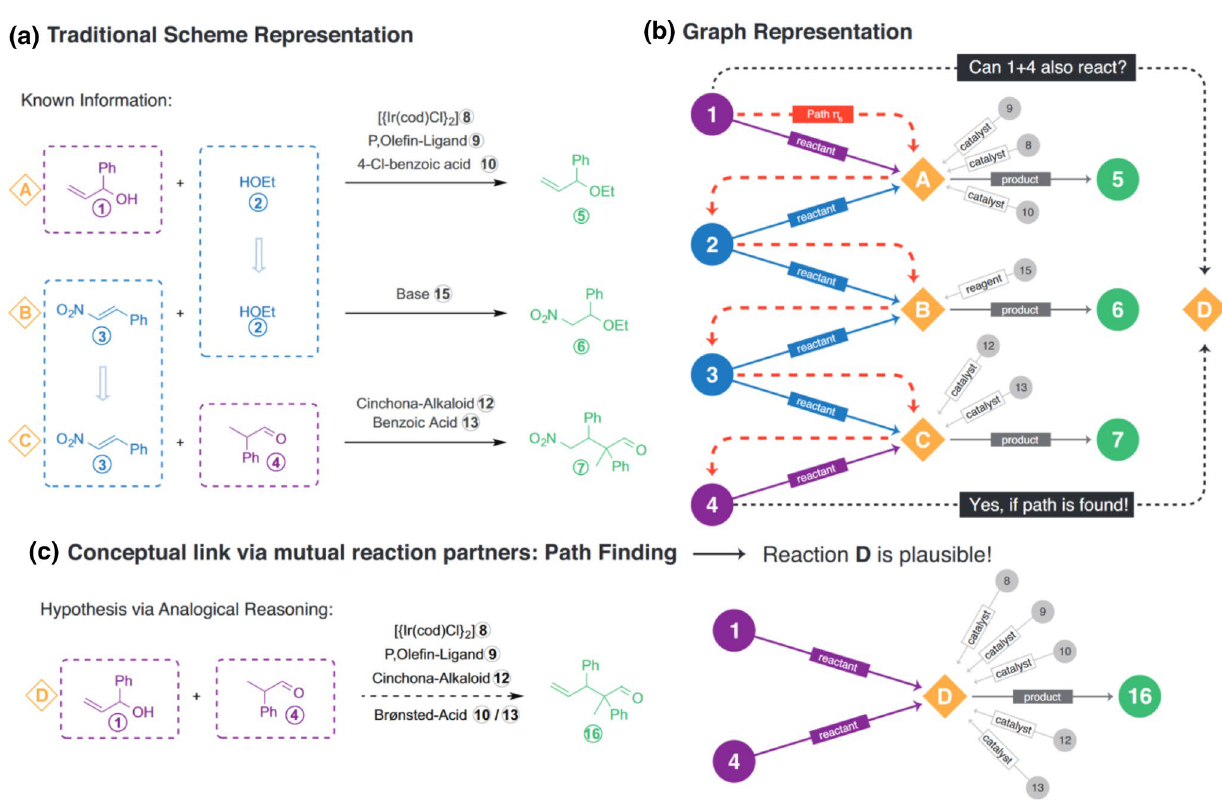
Fig. 5 Graph representation of reactions. a Four molecules, 1, 2, 3, and 4, and three reactions, A, B, and C. b The graph representation in which the circles represent the molecule nodes, and the diamonds represent the reaction nodes; edges describe the role, reactant, rea- gent, catalyst, solvent, or product of each molecule in a given reaction. Notice the path, depicted in orange color, made of reactant edges between molecules 1 and 4. c The missing reaction node D that was indicated by the reactant path found between 1 and 4. Reproduced with permission from the work of Segler and Waller